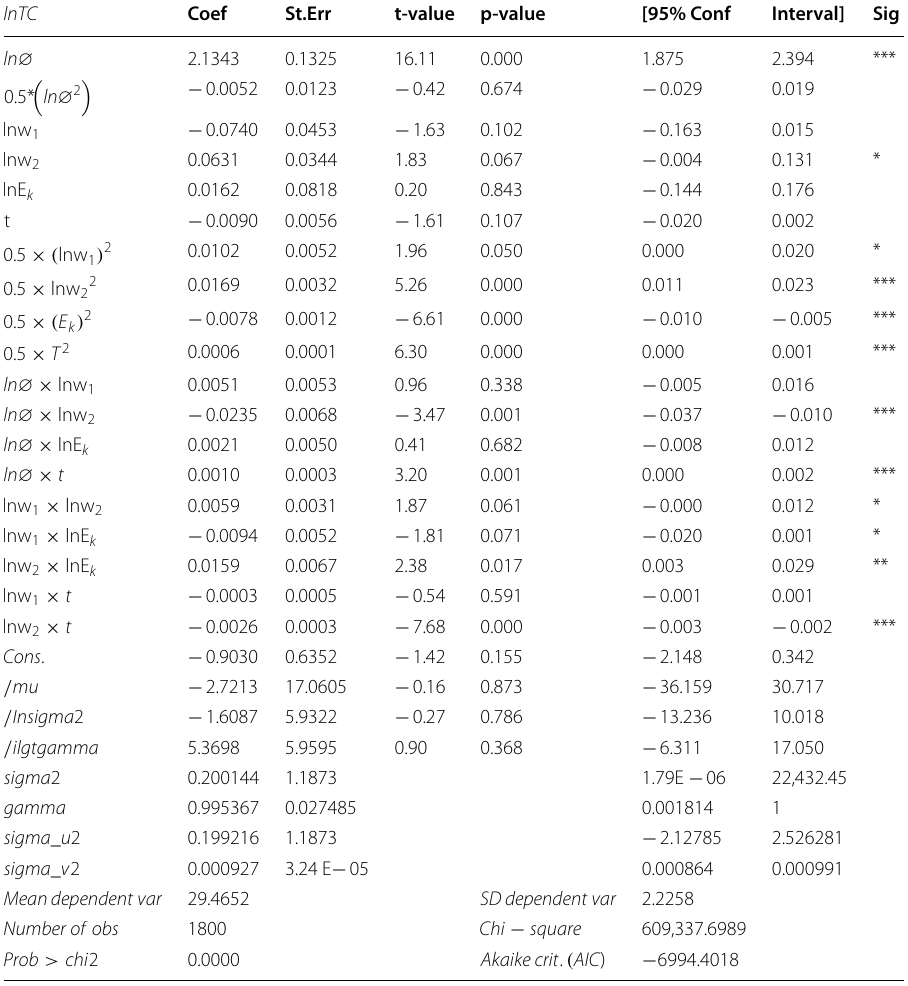
Table 6 Regression result of the estimated Trans-log cost function (Eq.